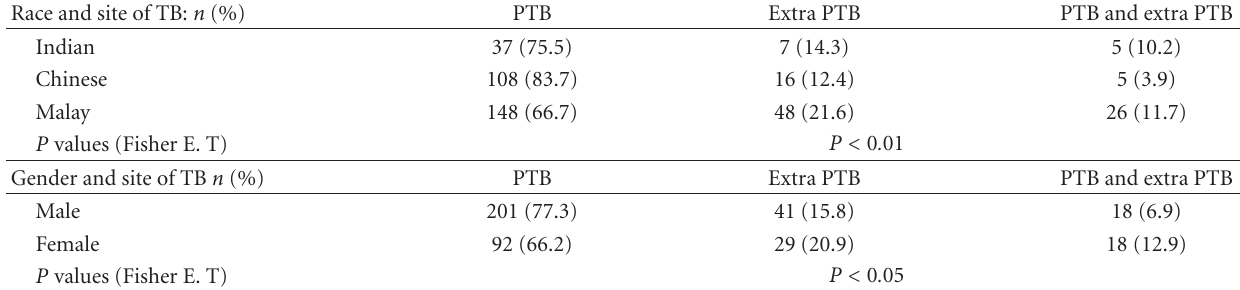
Table 4: Race and gender and anatomical site of TB infection.